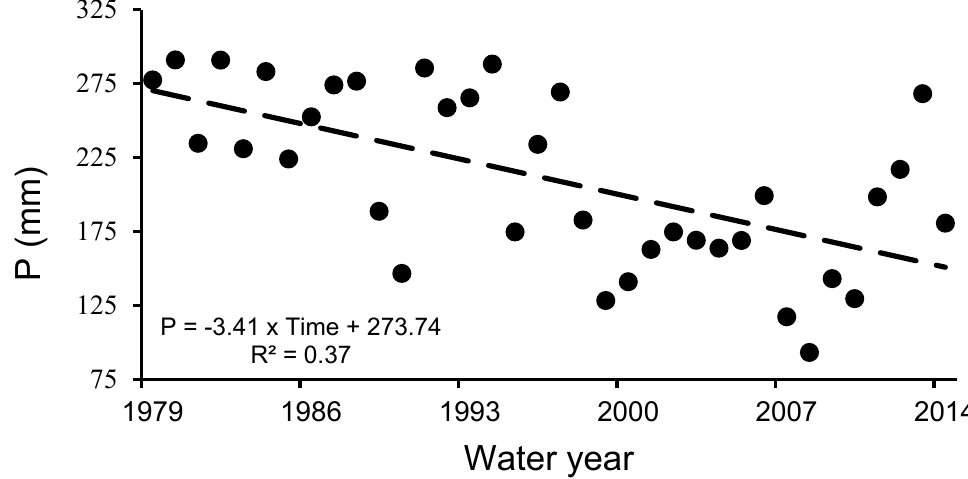
Figure 3. Temporal variations and the trend of annual average precipitation (P) that was estimated by applying the Thiessen Network method over Iraq during the time period between 1979 and 2014. However, Figure 4 displays the long-term spatial distribution precipitation variation over the studied region. The long-term analysis of precipitation indicates that the average annual values vary spatially from 84.38 to 233.46 mm and from 233.46 mm to 978.85 in the southern, western, central, and northern parts of the country, respectively (Figure 4). It is important to note that the upper part of Iraq had greater precipitation amounts than the lesser one (Figure 4). Furthermore, the average annual values vary spatially from 172 to 845 mm, 101 to 149 mm, 82 to 196 mm, and 90 to 201 mm in the northern, western, middle, and southern parts of the country, respectively. The corresponding values of standard deviation varied between 58 and 291 mm, 44 and 68 mm, 33 and 68 mm, and 33 and 67 mm in this order. The average annual precipitation varies spatially from 89 mm at Samawa station, which is situated in the southern portion of the country, to 845 mm at Soran station, which is situated in the northern part. The northern part receives precipitation of more than 500 mm. However, in the western and southern areas, the annual precipitation varied from 68 to 154 mm (Figure 4). The coefficient of variation C V , which is the degree of spreading around the average, was also estimated to investigate the spatial inconsistency of annual precipitation for every weather station. This coefficient varied between 29.2 and